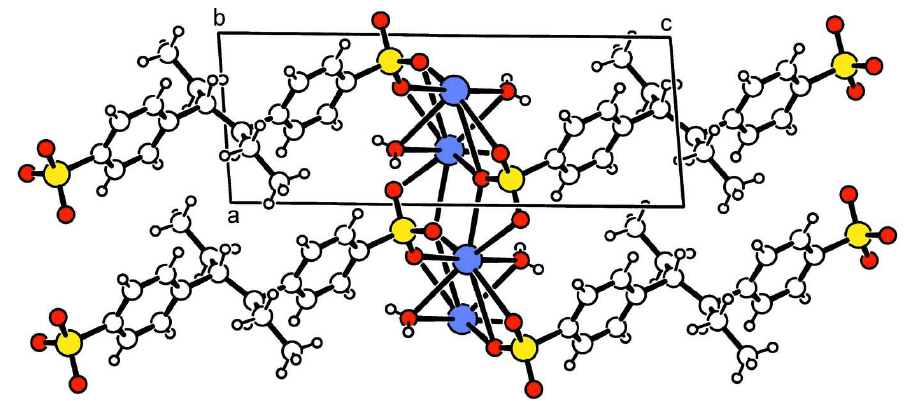
Figure 1 The structure of the title compound, with displacement ellipsoids at the 50% probability level. [Symmetry code for unlabeled atoms: 1-x, -y, -z.]